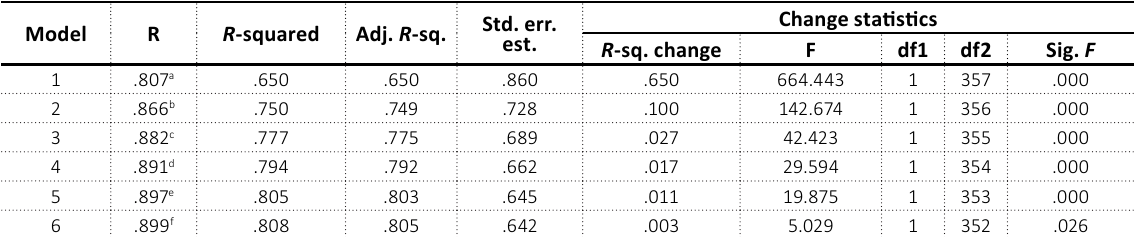
Table 3. Coefficient of determination value ( R -squared) model